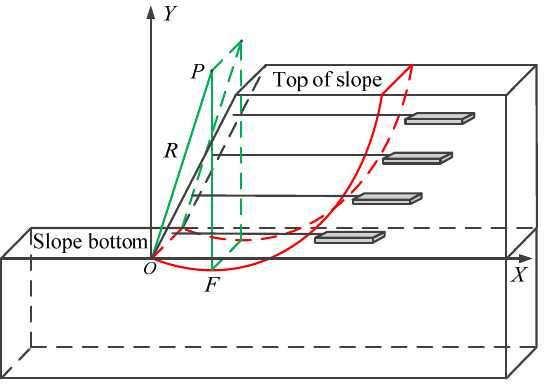
Figure 6. Schematic diagram of slope toe circle 2.